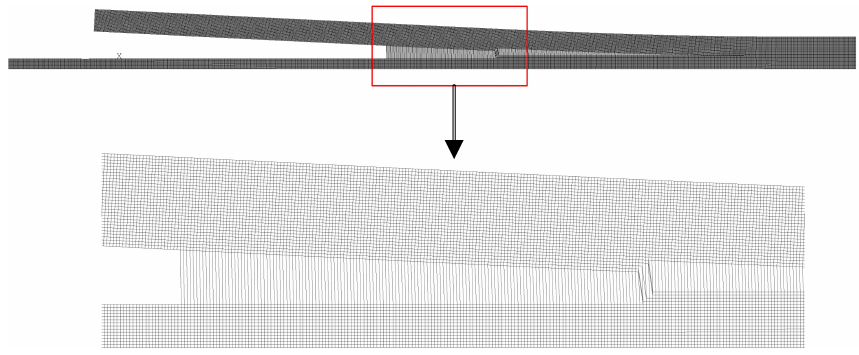
Figure 9. Deformed shape in delamination migration.